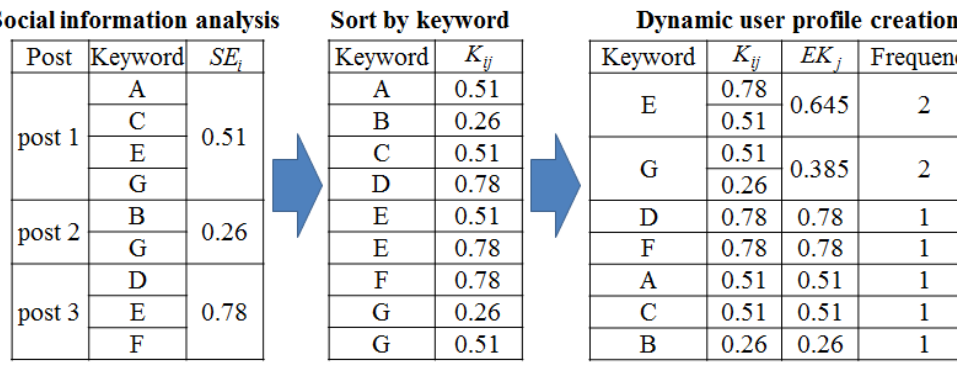
Figure 4. Dynamic user profile creation process.